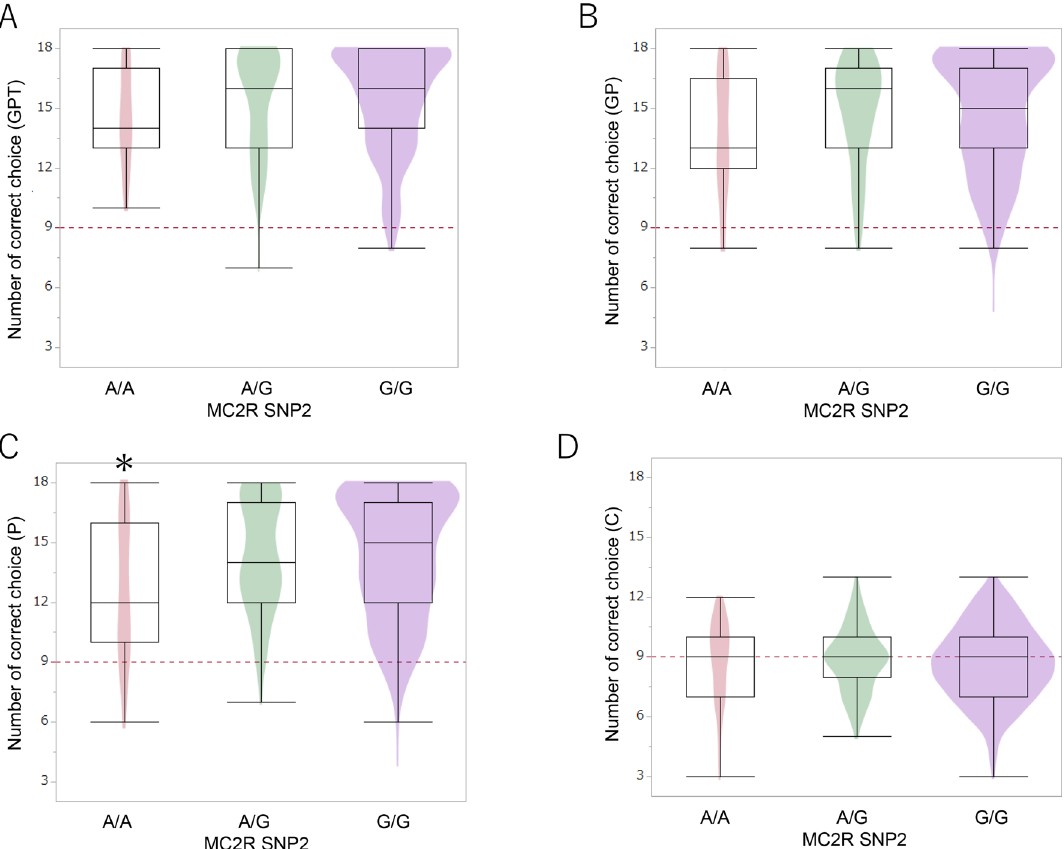
Figure 3. Allelic comparisons of MC2R SNP2 polymorphisms in the two-way choice test. In the pointing test (C), dogs with the A/A allele showed fewer correct choices than dogs with the A/G or G/G alleles. * p < 0.05 (GLM followed by Bonferroni post-hoc